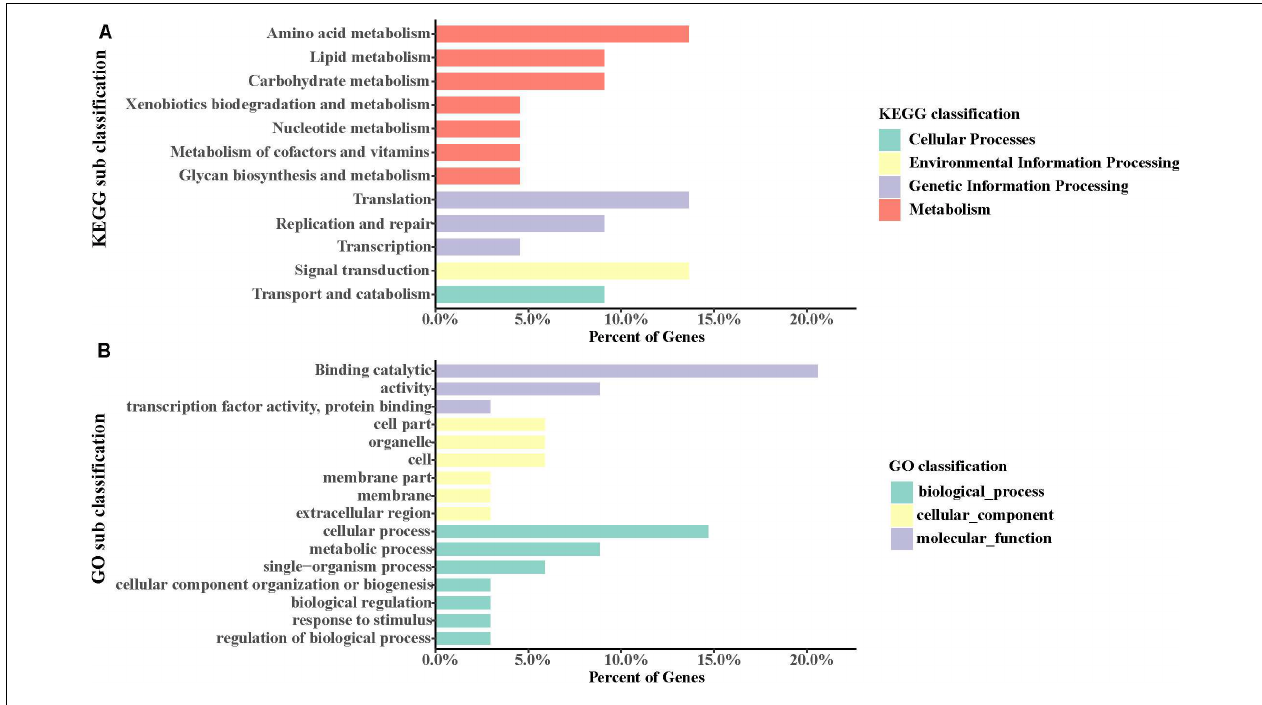
FIGURE 6 | (A,B) Positive gene assignments in GO and KEGG pathway, respectively. TABLE 2 | Positively selected genes associated with immune from